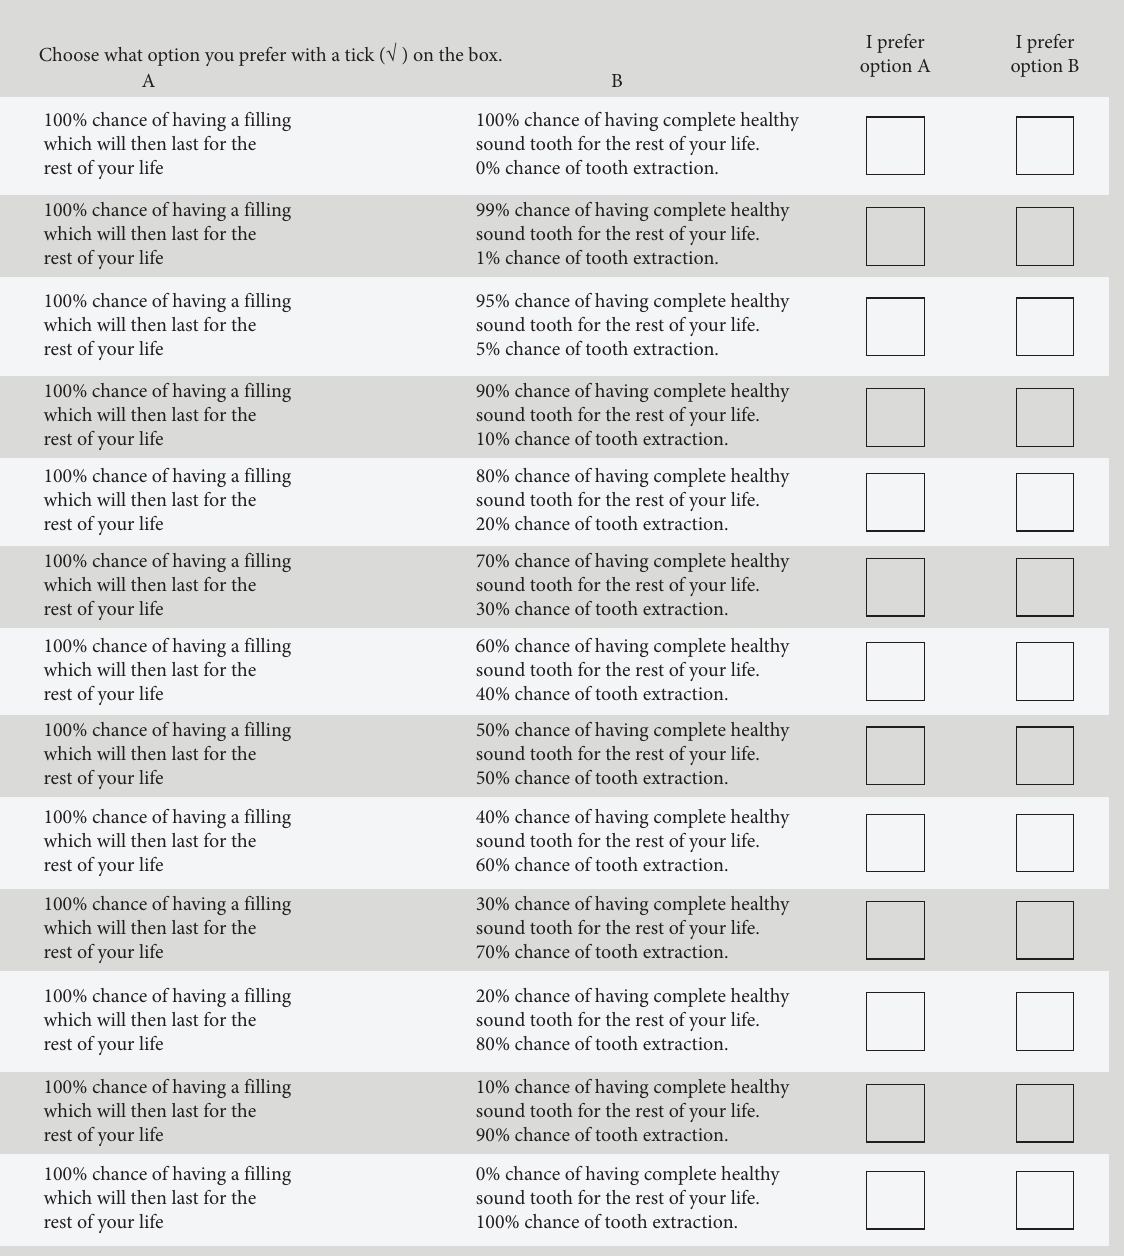
Figure 2: An example of the questionnaire used in this study. Te four intermediate tooth health state alternatives were presented as option A one at a time